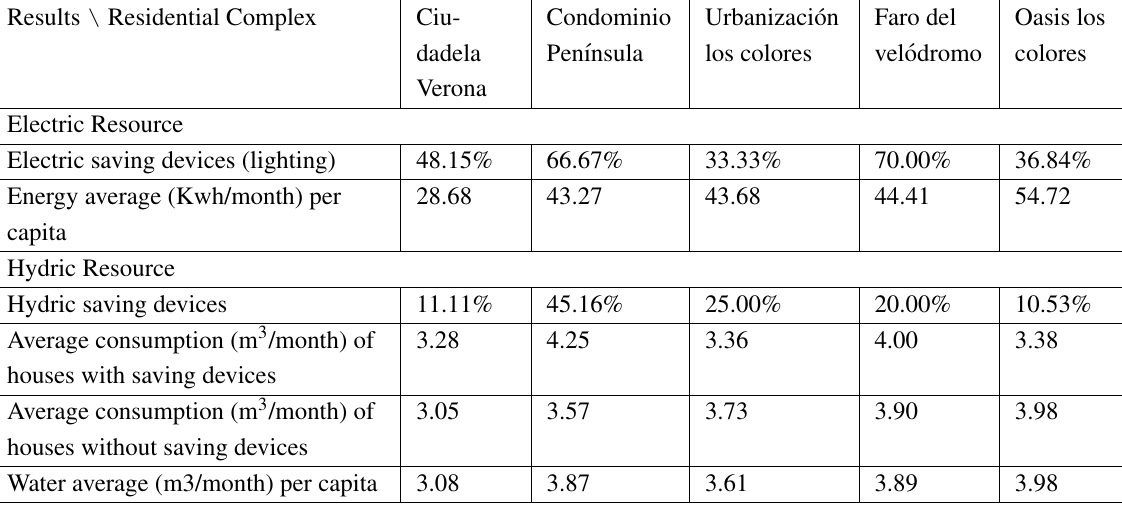
Table 5. Consumption of water and energyin the projects